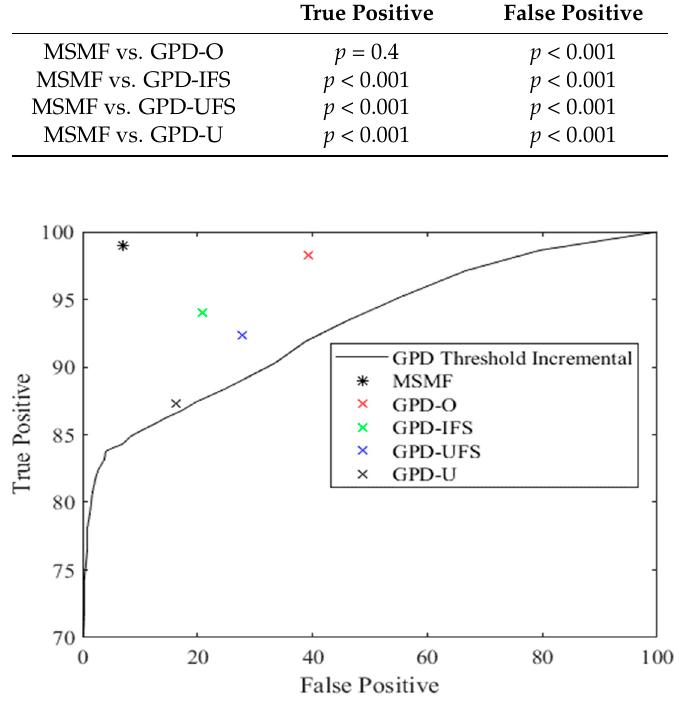
Figure 9. Correctly classified vs. false classified strides for various conditions. The solid line represent the GDP results obtained by changing the threshold value from 80% to 20% of the peak value.